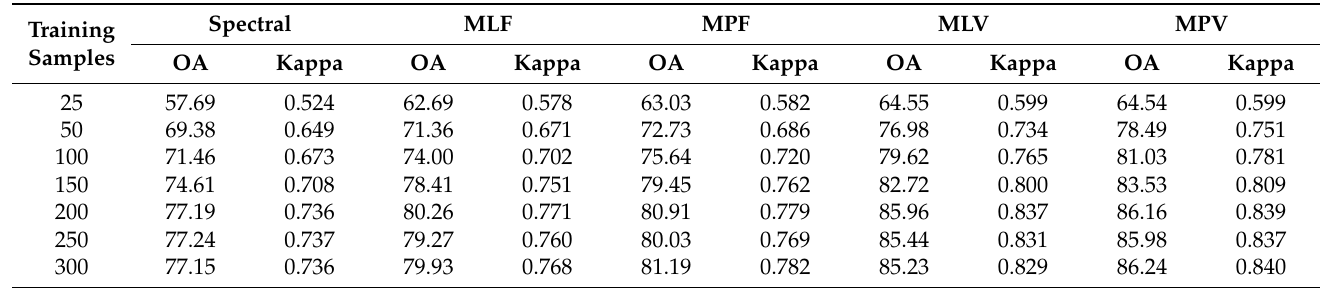
Table 8. OAs (%) and Kappa coefficients obtained by different methods for the Hanchuan dataset using RF with different numbers of training samples per class.